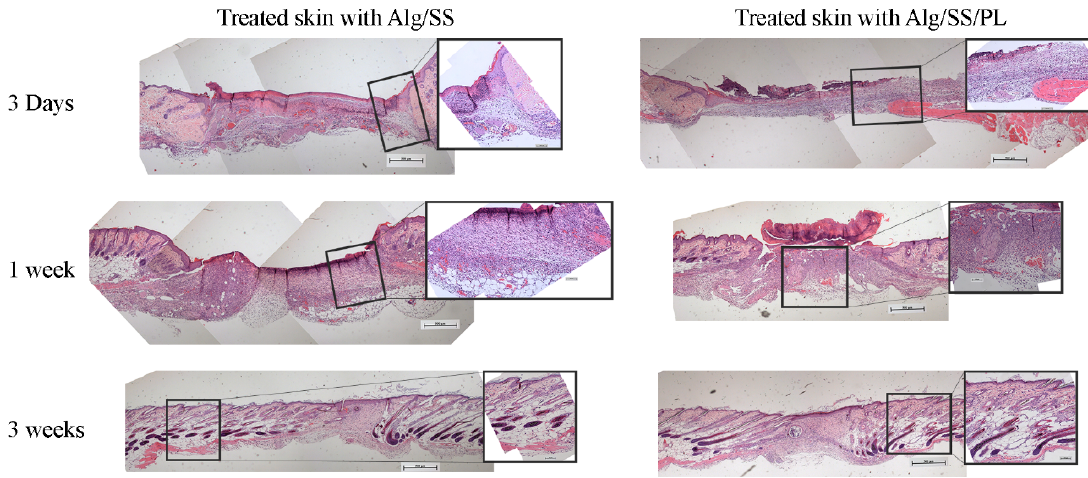
Figure 8. Histological analysis of skin lesions. Histology of lesions treated with Alg/SS and Alg/SS/PL biomembranes. Bioptic sample sections were cut at 3 µm thickness and stained with haematoxylin- eosin. Images were acquired at 5× magnification (0.5 mm scale bar) and 20× magnification (0.1 mm scale bar).